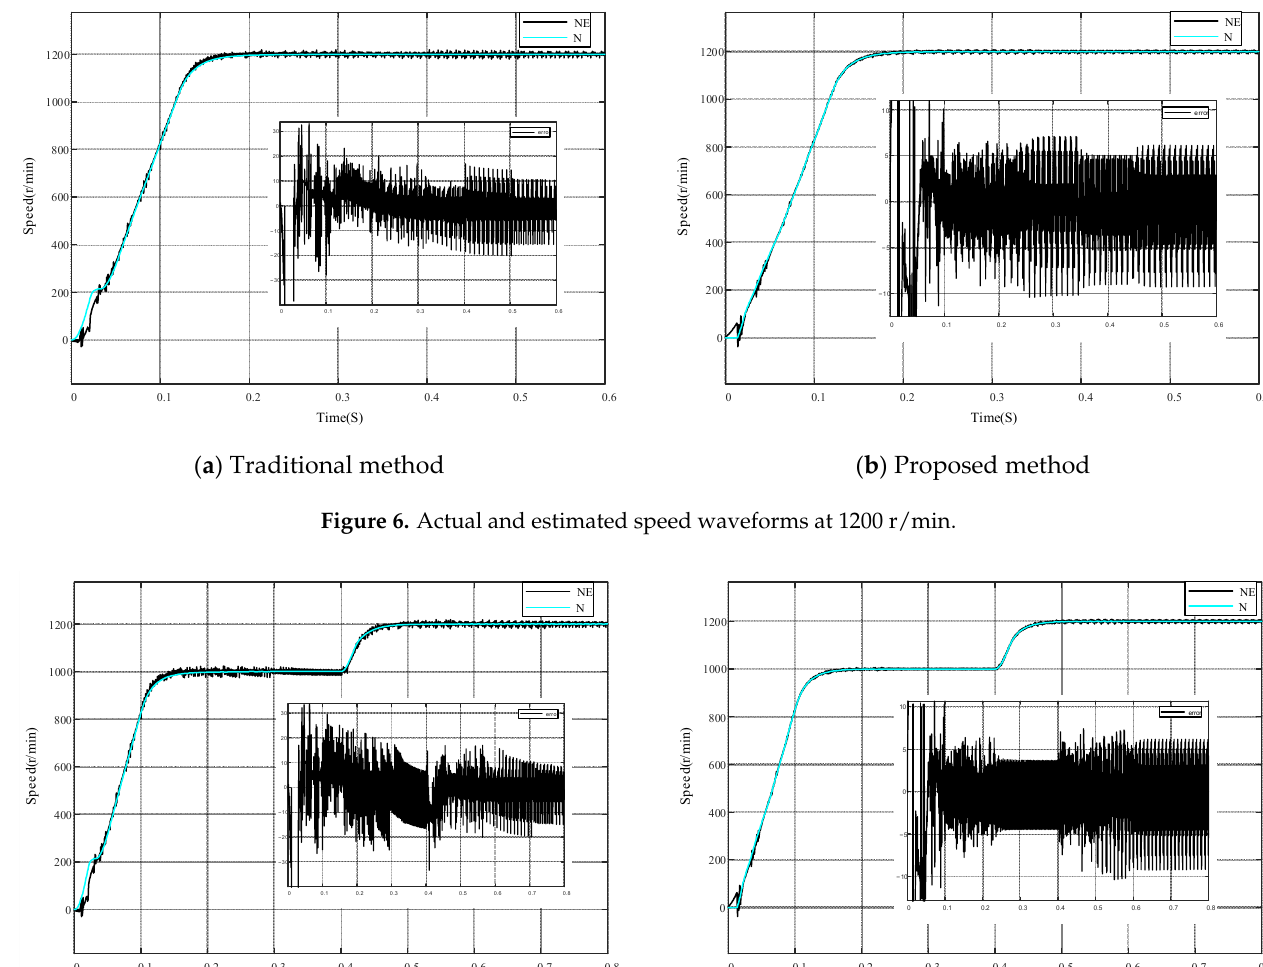
Figure 5. Actual and estimated speed waveforms at 1000 r/min. In Figure 6, the motor speed is 1200 r/min. After the motor runs stably, the speed estimation error obtained by using the traditional method is 12 r/min, while the speed estimation error obtained by using the proposed method is 7 r/min.